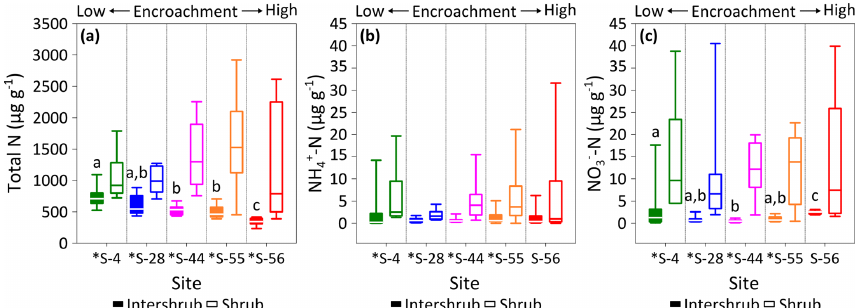
− N (b) , and NO − − N (c) concentrations for surface soil (top 10cm) by dry weight under inter-shrub and shrub Figure 5. Total N (a) , NH + 4 3 cover types along a shrub encroachment gradient in the Santa Rita Experimental Range, AZ, US ( n = 9). Boxes denoted with different letters indicate significant differences by cover type at p <0.05 (Dunn’s test). Inter-shrub and shrub soils at sites denoted with an asterisk differ significantly from each other at p <0.05 (Mann–Whitney U